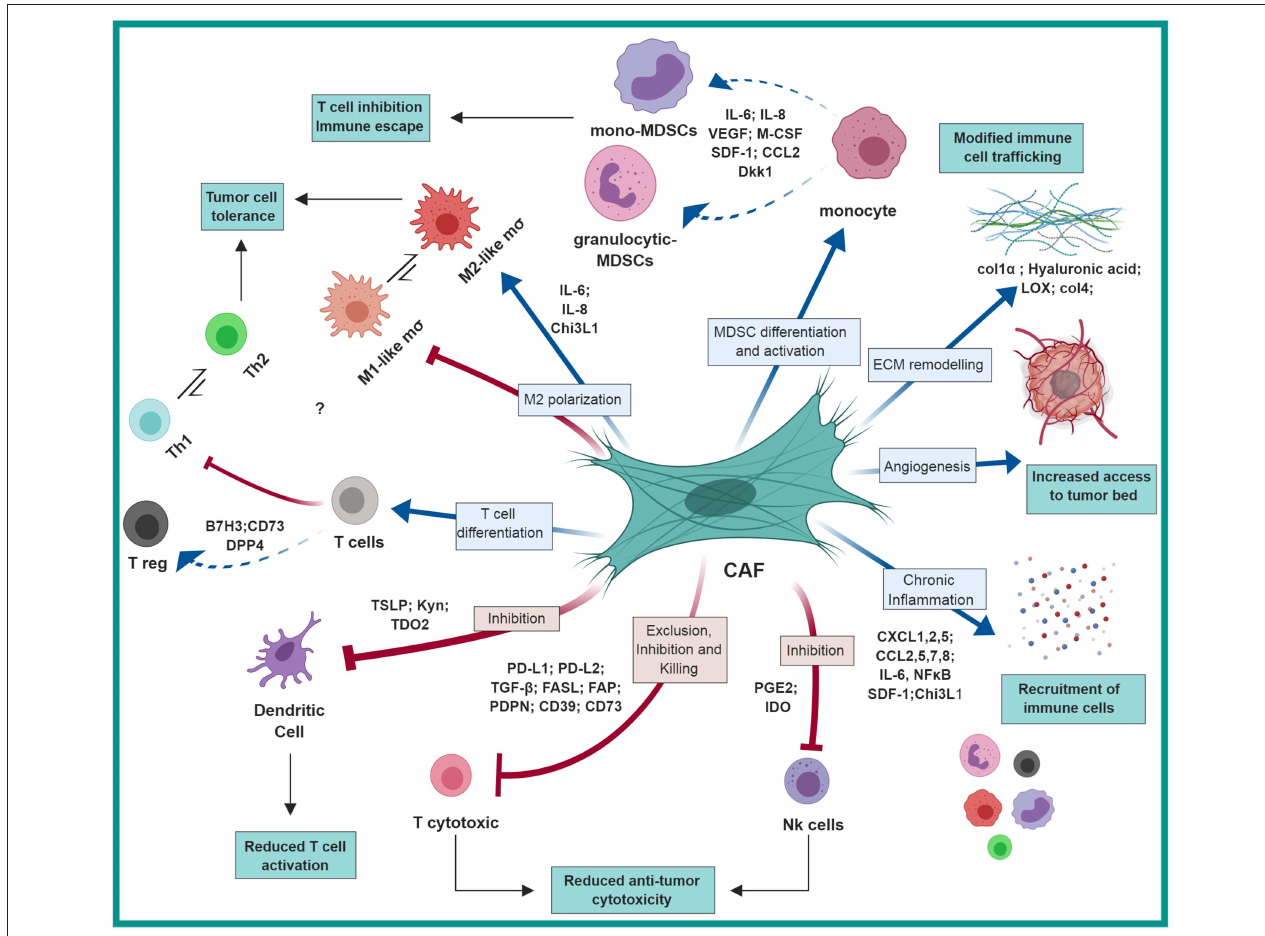
FIGURE 1 | CAF-mediated immunosuppression: CAFs shape the immune microenvironment in tumors toward a pro-tumorigenic and immunosuppressive milieu by affecting the recruitment and function of various innate and adaptive immune cells. Red arrows represent negative regulation/inhibition and blue arrows represent positive regulation/induction. This figure was designed by using graphical elements from